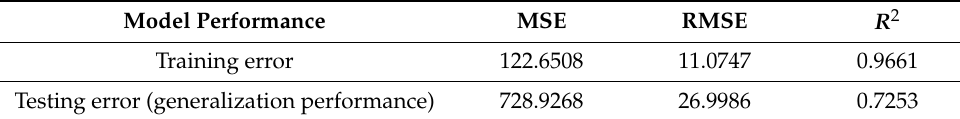
Table 14. The performance of the optimal RF model.